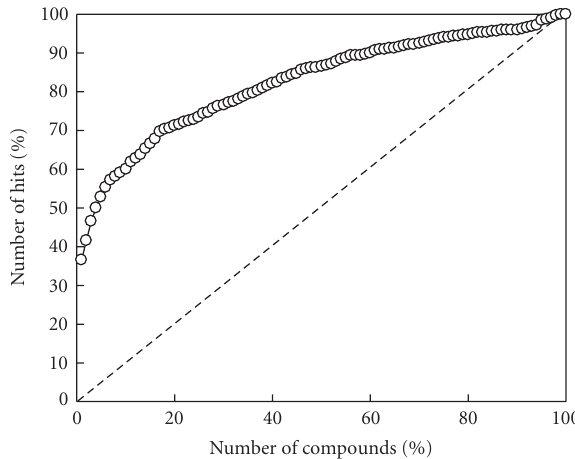
Figure 3: Average database enrichment curves of 160 active compounds with the current similarity measure. Open circles represent the average database enrichments with the distance measure defined by (6) (MGD) with λ = 0 . 25. The dashed line represents the random screening